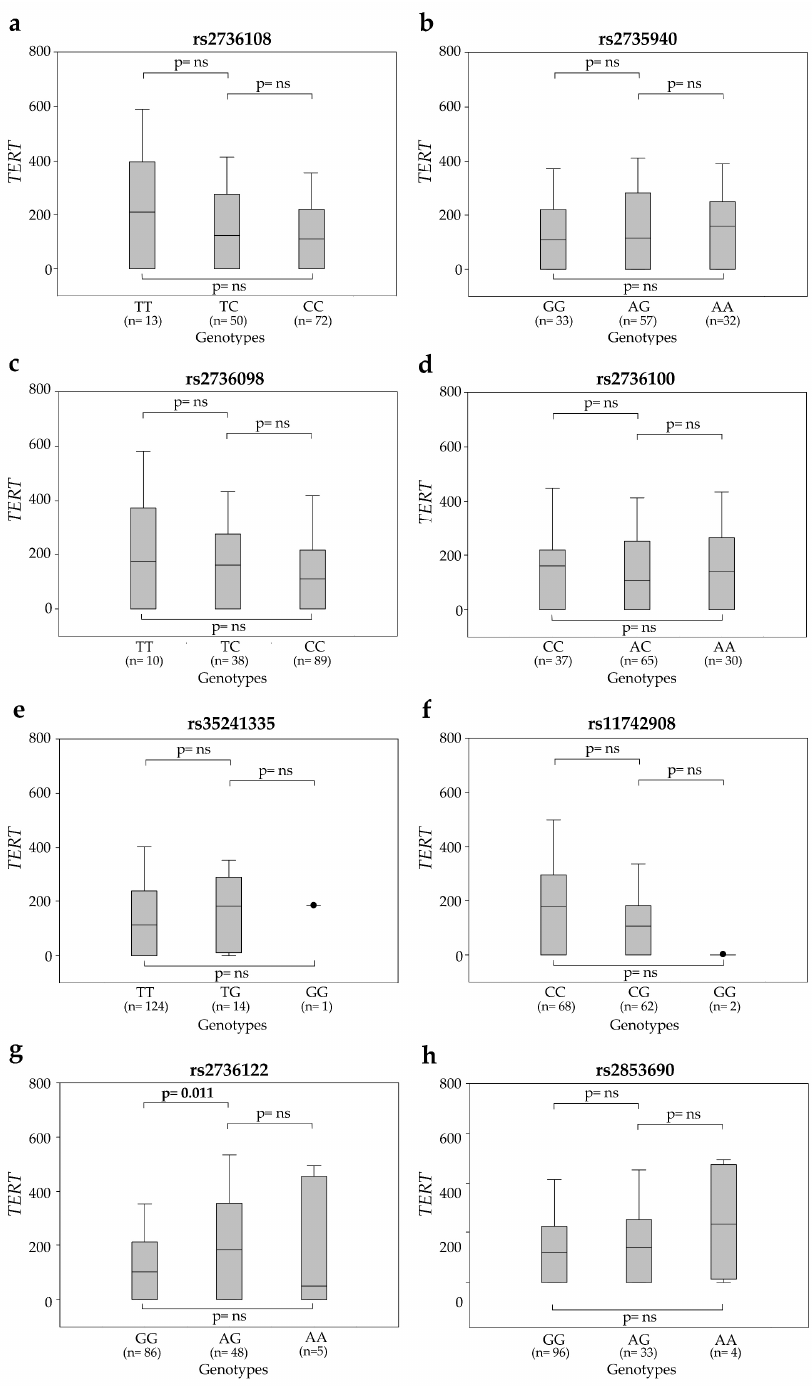
Figure 3. Levels of circulating TERT mRNA at T0 according to SNP genotypes: ( a ) rs2736108, ( b ) rs2735940, ( c ) rs2736098, ( d ) rs2736100, ( e ) rs35241335, ( f ) rs11742908, ( g ) rs2736122 and ( h ) rs2853690. Boxes and whiskers: 25–75th and 10–90th percentiles, respectively; central line in boxes: median.